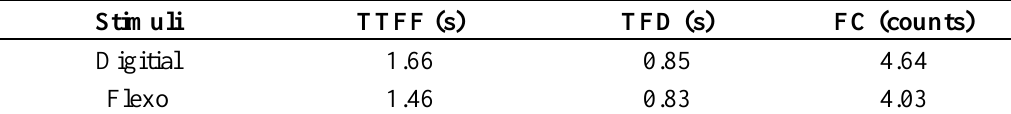
Table 2. Overview of eye tracking